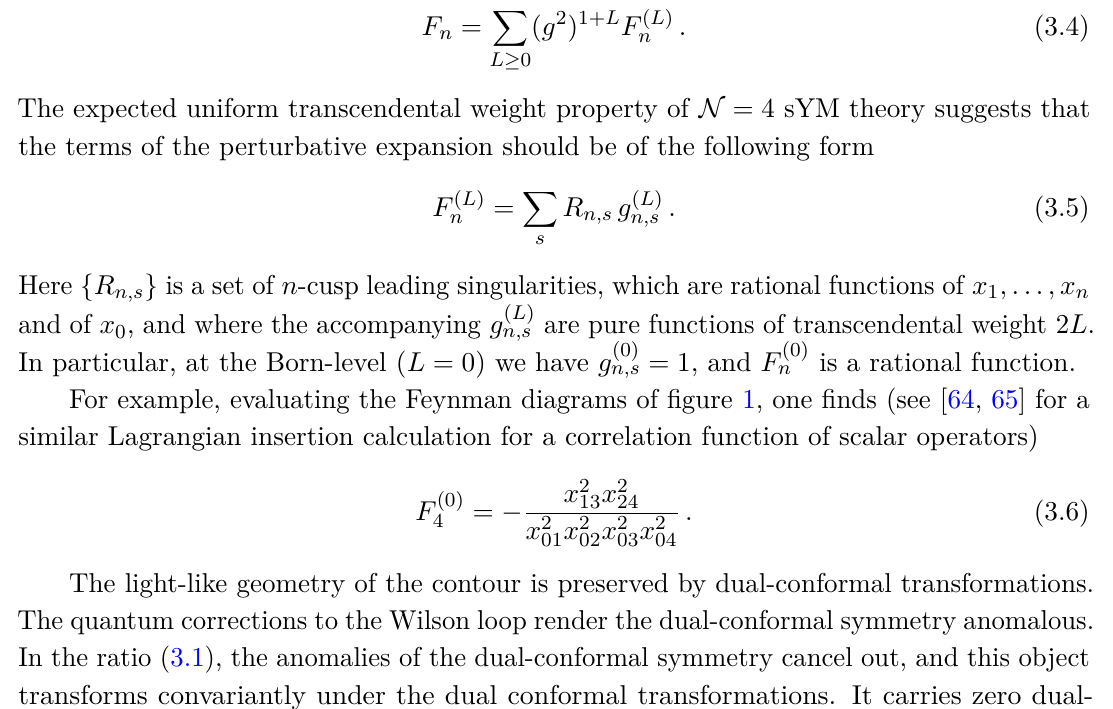
, i.e. at order g 2 4 YM